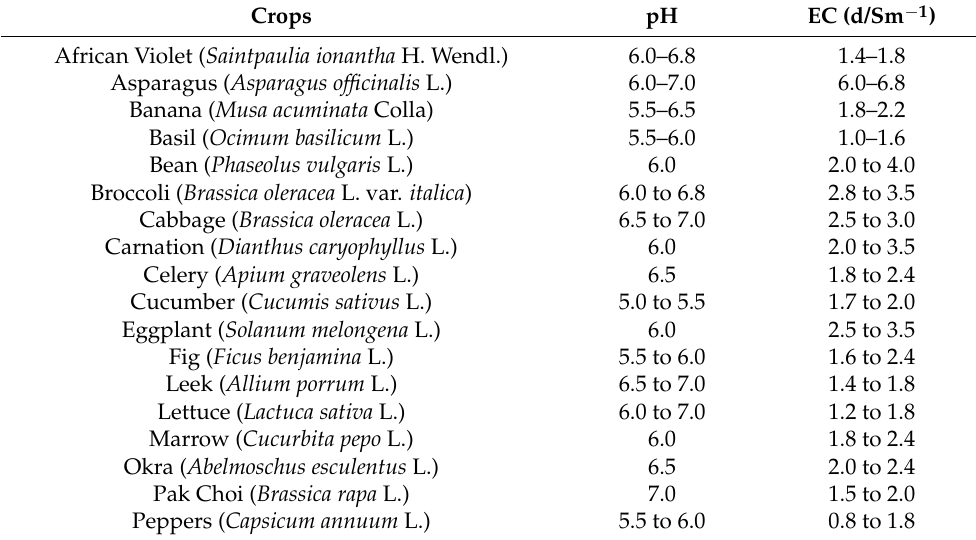
Table 1. The optimum range of electrical conductivity (EC) and pH of common hydroponically grown crops. Crops pH EC (d/Sm − 1 ) African Violet ( Saintpaulia ionantha H. Wendl.) Asparagus ( Asparagus officinalis L.)